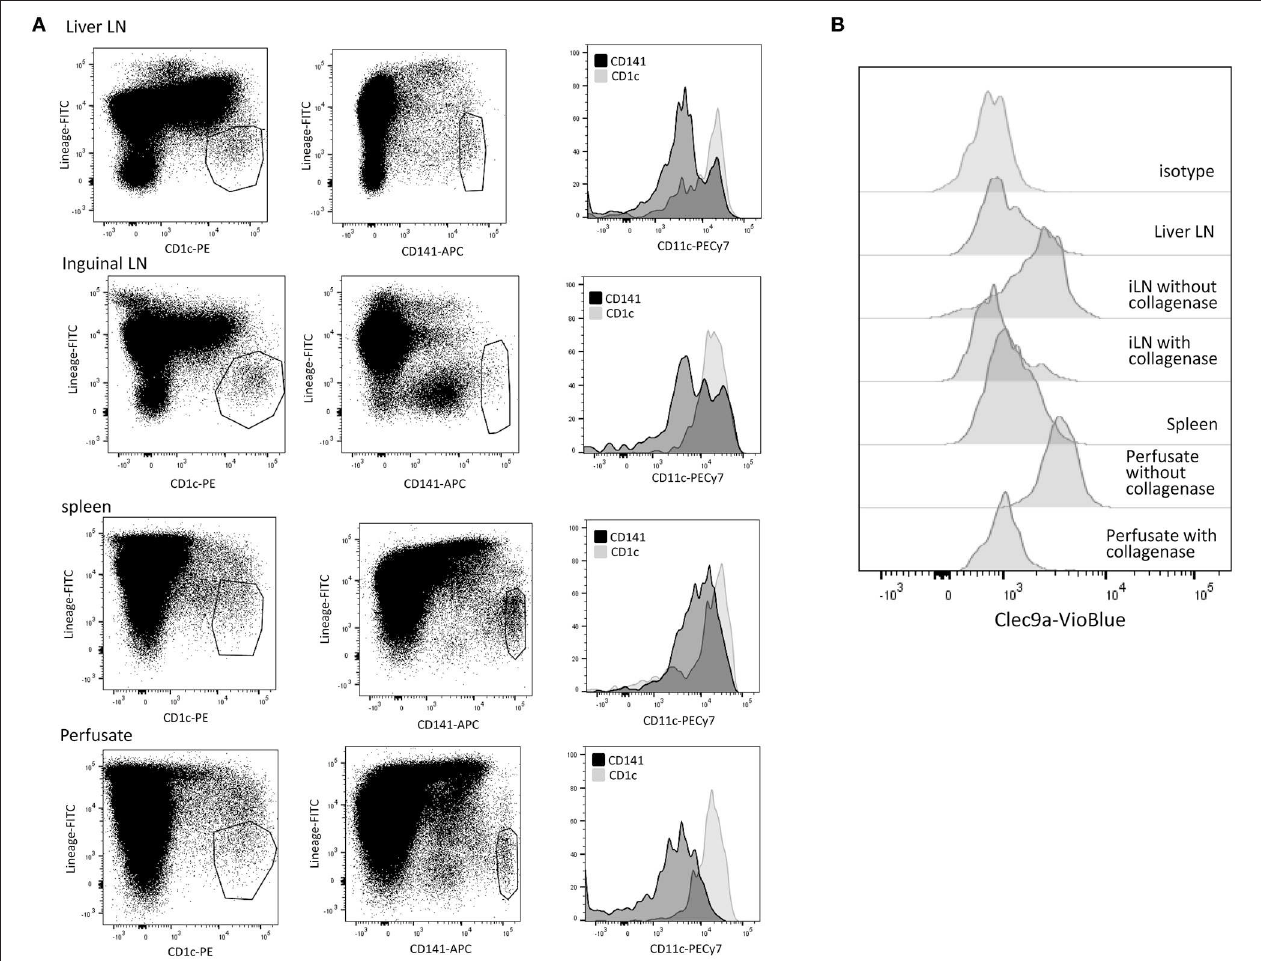
FIGURE 1 | Characterization of cDC subsets in hepatic and inguinal lymph nodes, spleen, and liver. (A) Vital (7-AAD − )CD45 + Lineage − CD1c + and CD45 + Lineage − CD141 + cells were gated in MNC isolated from hepatic and inguinal lymph nodes, spleen and liver perfusate, and analyzed for CD11c expression. (B) Vital (7-AAD − )CD45 + Lineage − CD141 bright cells were analyzed for Clec9A expression. Cells isolated from lymphoid tissues showed low Clec9A expression, while their counterparts in liver perfusate were Clec9A + . When liver perfusate cells were incubated with collagenase, Clec9A expression was lost. When leukocytes were isolated from inguinal LN without collagenase digestion, Clec9A was expressed on cDC2. iLN, inguinal LN.